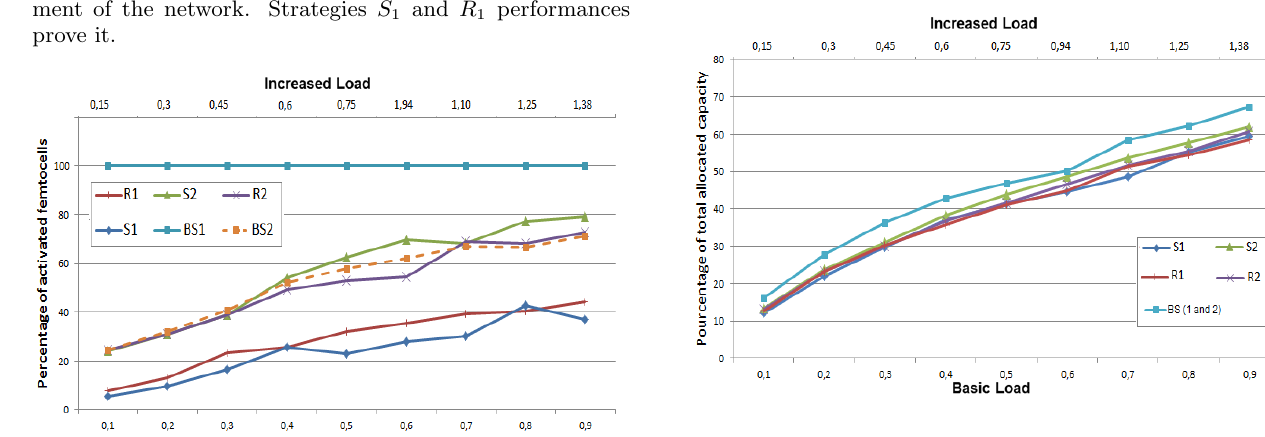
Figure 6: Percentage of total allocated